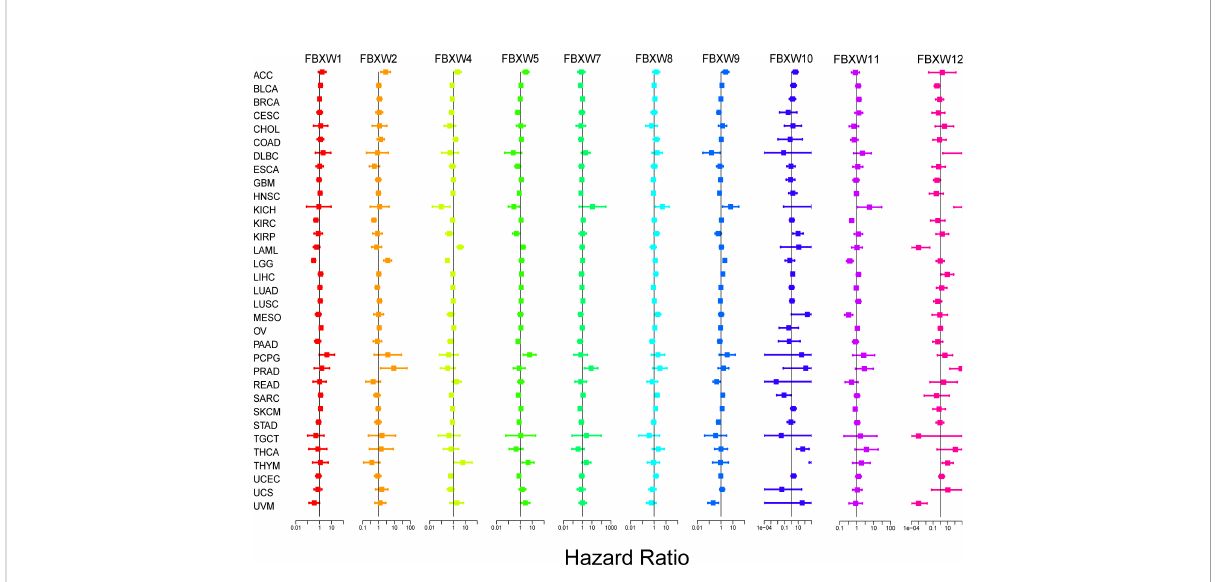
FIGURE 7 Correlation analysis of FBXW family gene expression with survival by the COX method in different types of cancers. Different colored lines indicate the risk value of different genes in tumors, hazard ratio <1 represents low risk and hazard ratio >1 represents high